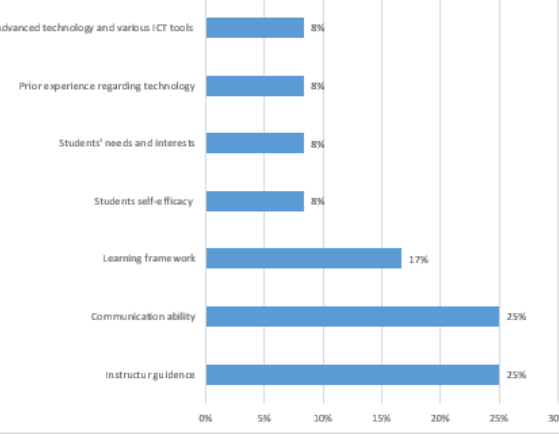
Figure 5: Influential factors in PBL with technology